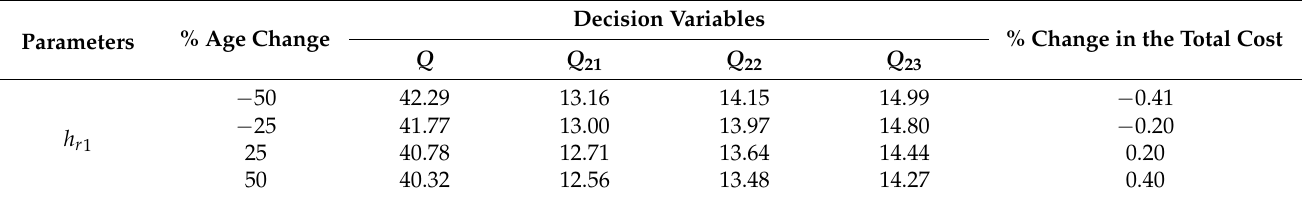
Table A7. Sensitivity analysis for holding cost of raw material of manufacturer and